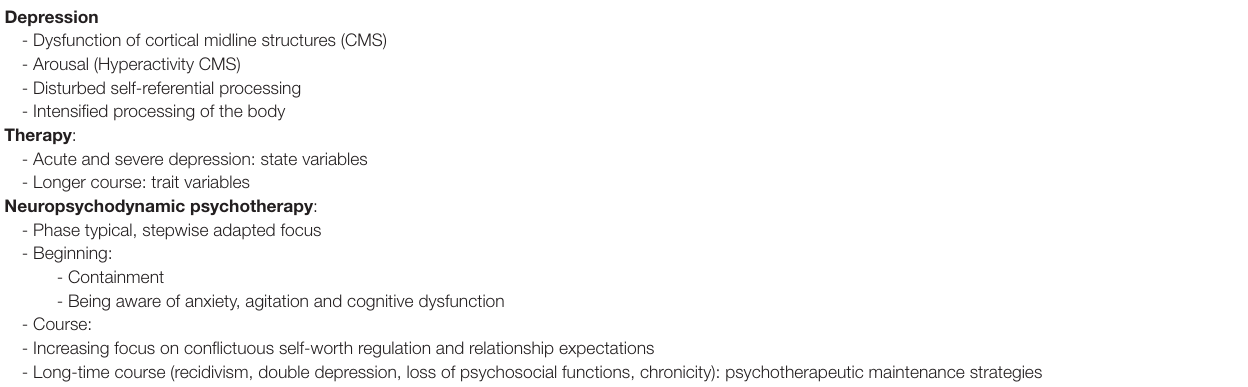
TABLE 1 | Neuropsychodynamic approach, psychotherapeutic attitude and therapeutic focus. Depression - Dysfunction of cortical midline structures